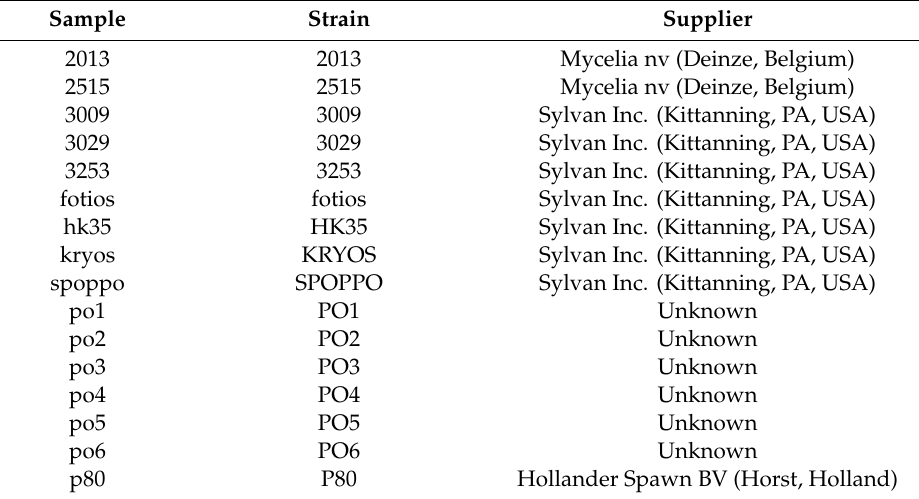
Table 1. Specification of the P. ostreatus basidiocarp